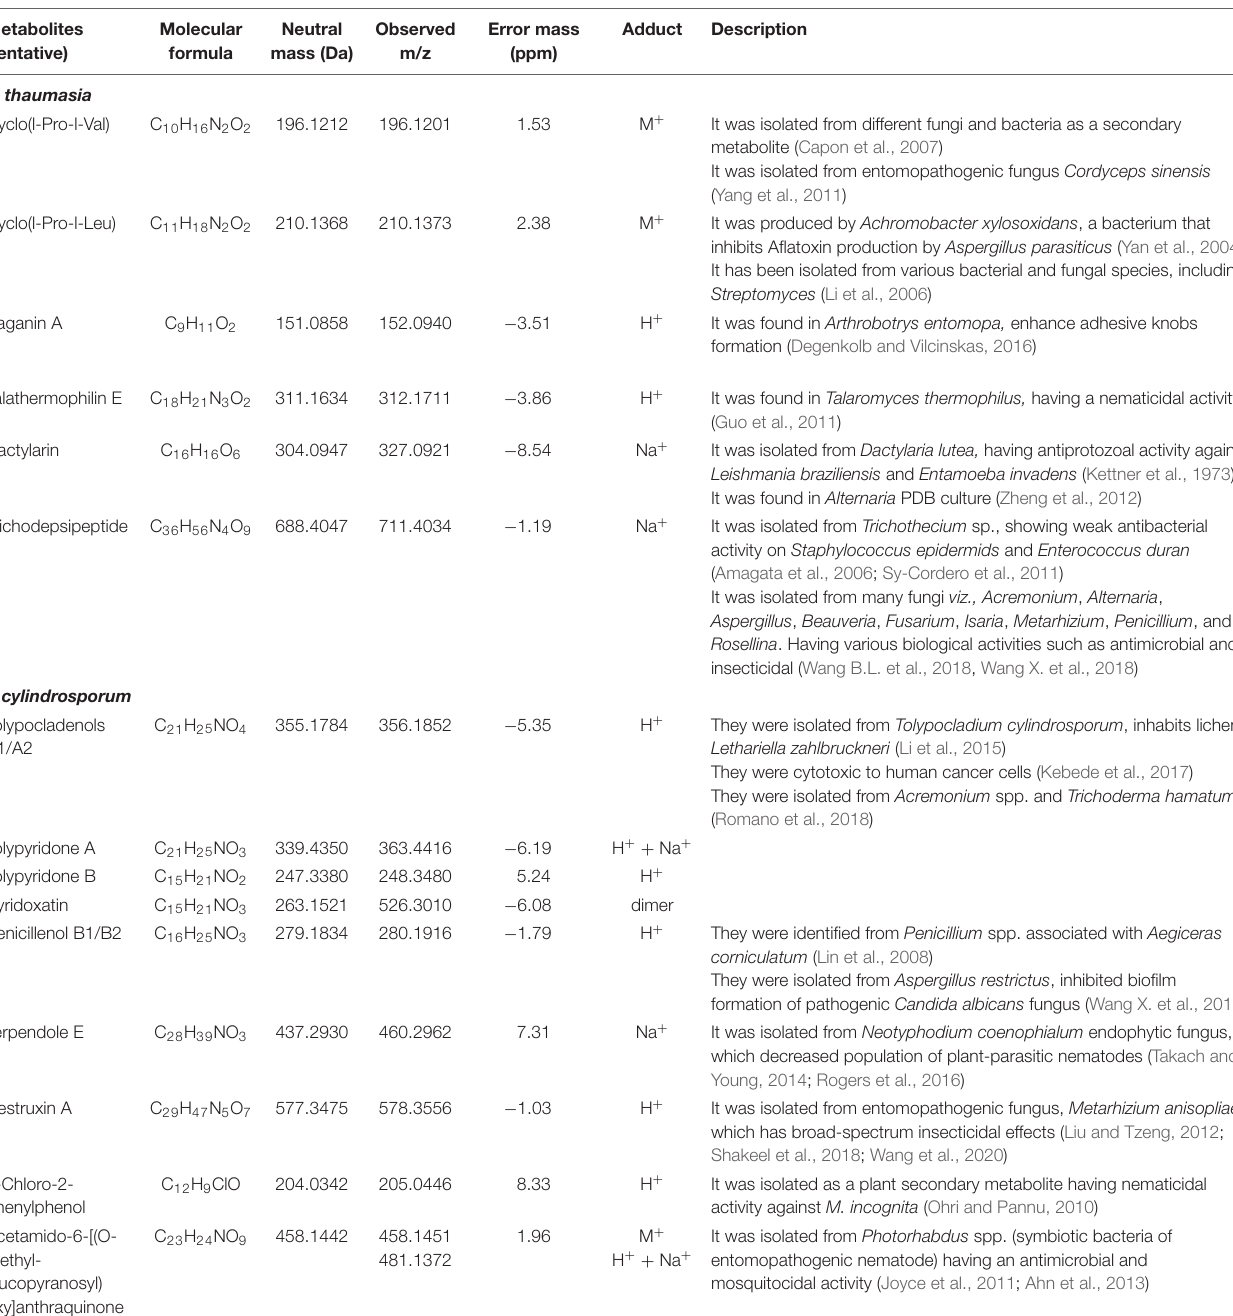
TABLE 3 | Identification of metabolites in A. thaumasia and T. cylindrosporum using UPLC-QToF-ESI-MS analysis. Metabolites Molecular (tentative)